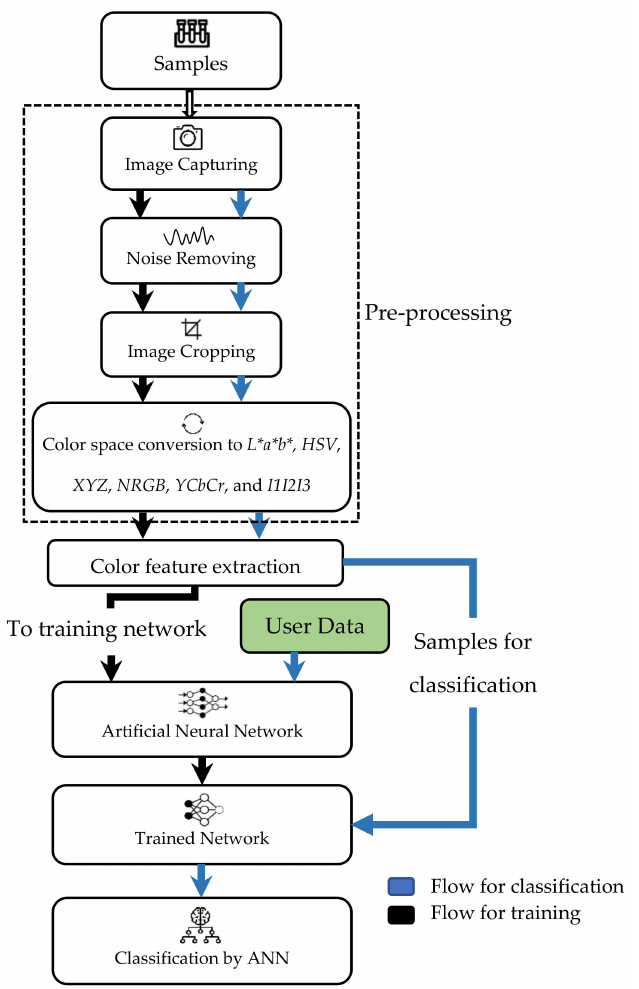
Figure 13. The main steps in the development of the program for honey classification using ma- chine